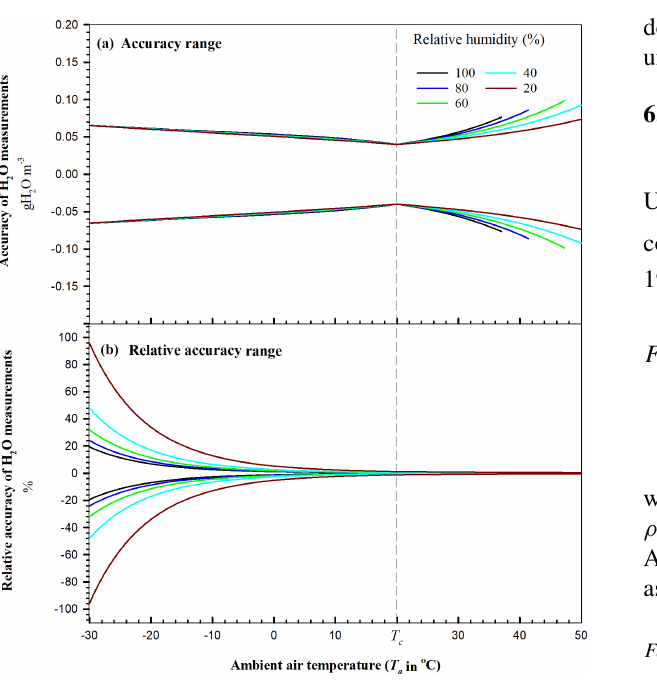
Figure 3. Accuracy of field H 2 O measurements from open-path eddy-covariance systems by EC150 infrared CO 2 –H 2 O analyzers (Campbell Scientific Inc., UT, USA) over their operational range in T a under atmospheric pressure of 101.325kPa. The vertical dashed line represents the ambient air temperature ( T c ) at which an ana- lyzer was calibrated, zeroed, and/or spanned. Relative accuracy of H 2 O measurements is the ratio of H 2 O accuracy to H 2 O